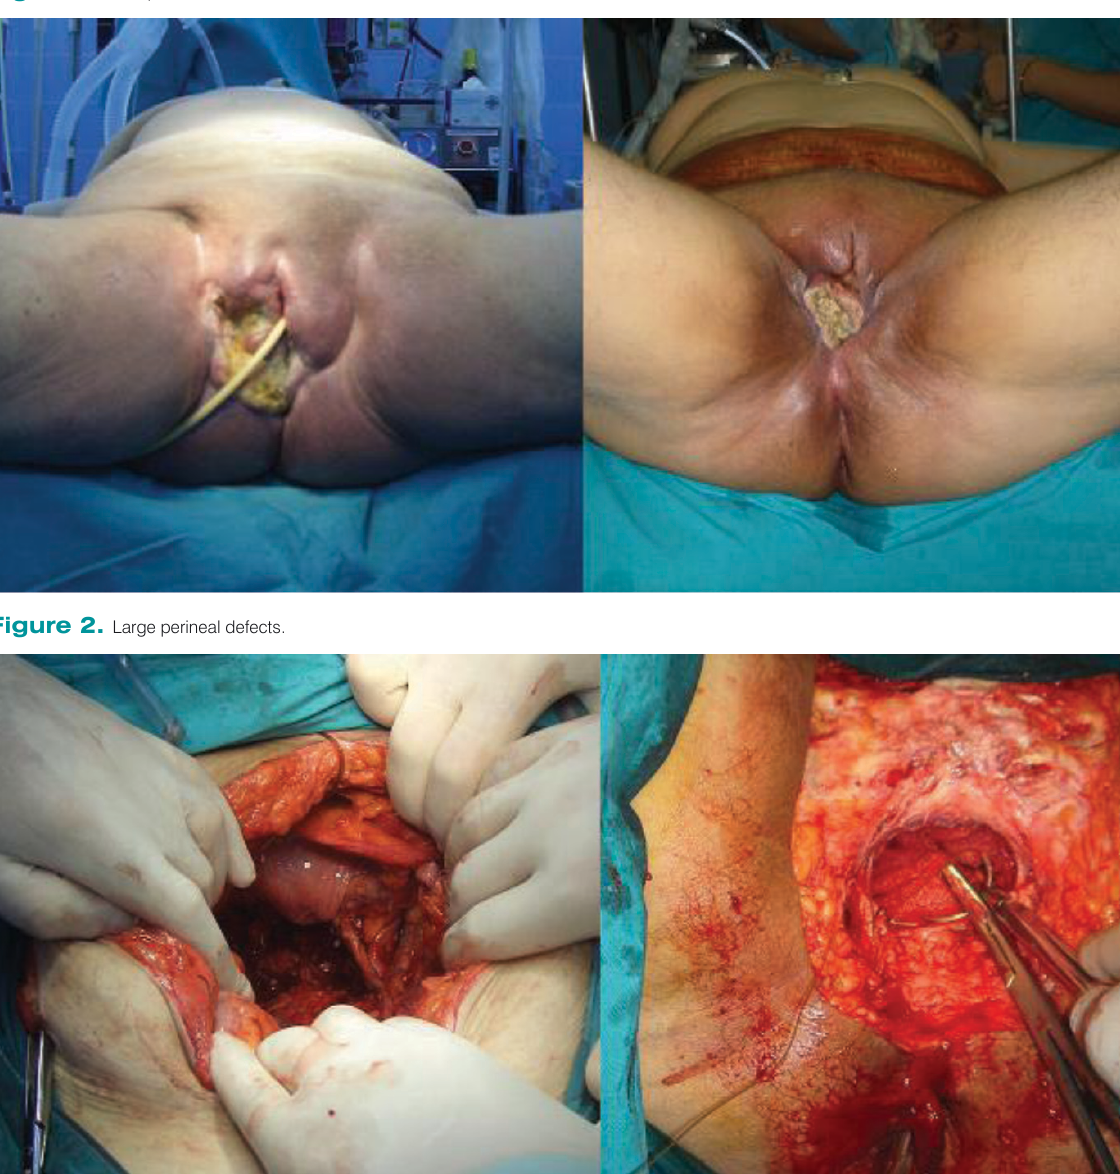
Figure 1. Preoperative conditions.